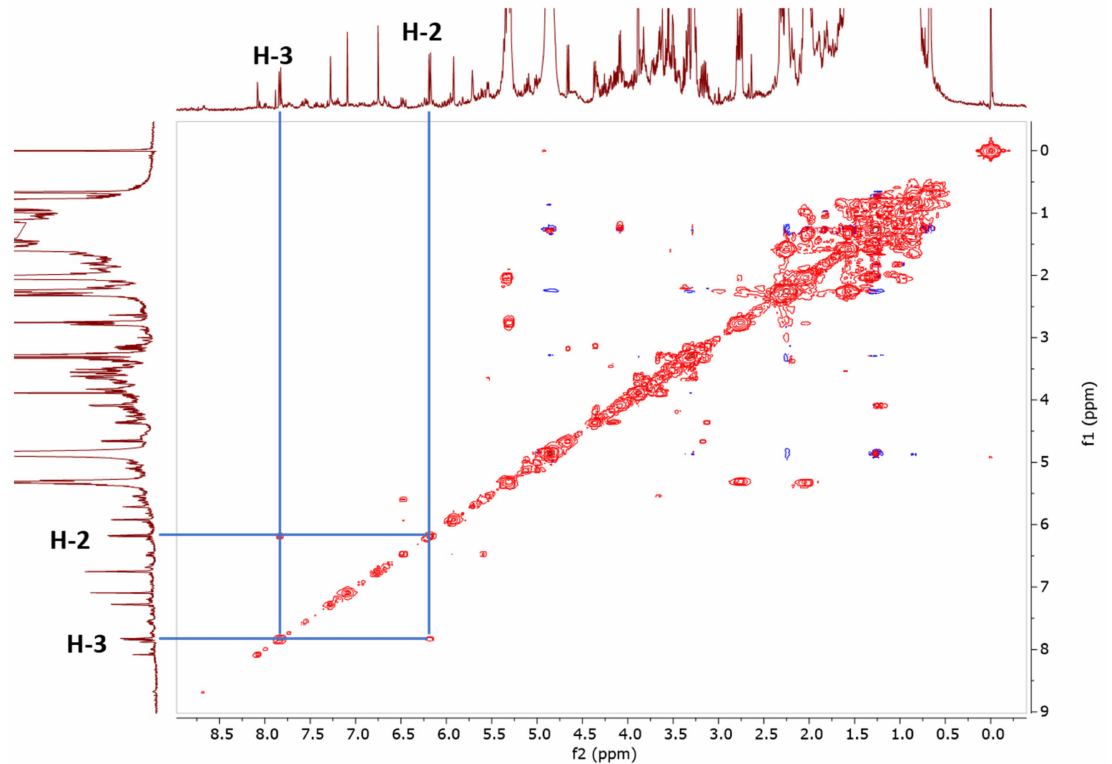
Figure 4. A correlation spectroscopy (COSY) spectrum of Paederia foetida twig chloroform